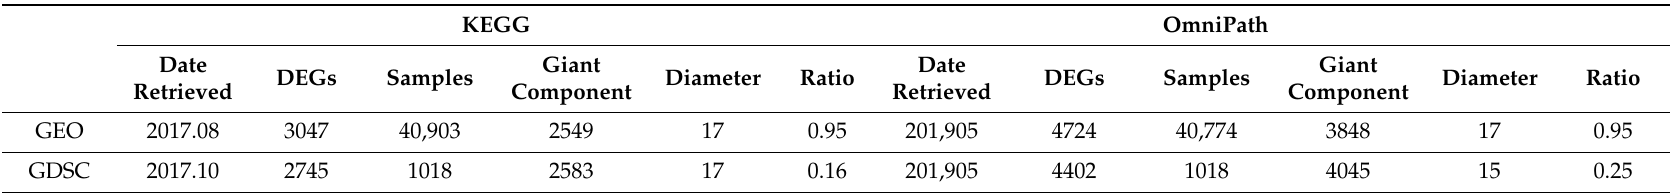
Table 2. General properties and date retrieved of the signaling networks. The number of di ff erentially expressed genes (DEGs) is also given, which are those common between the edge list genes and gene expression profile genes and identified by the GEO / GDSC database as either up- or down-regulated. Samples are the total number of samples in GEO and GDSC databases for which expression data were available for the given gene pair. The node number of the giant component, the diameter of the network, and the ratio of shared genes between edge list genes and gene-expression-profile genes are presented in the last three